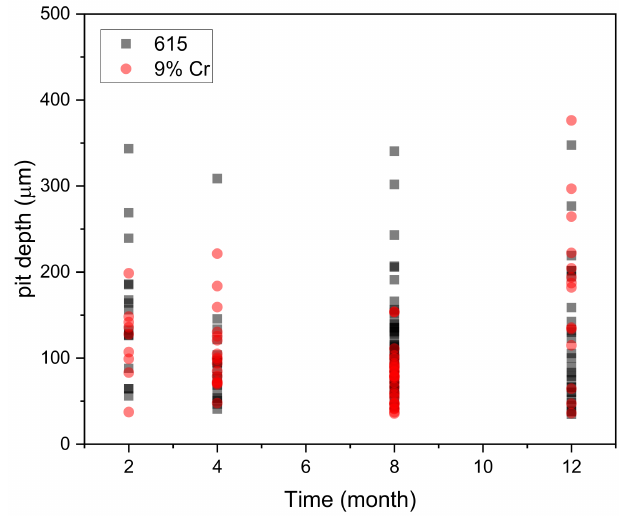
Figure 12. Pit depth distribution as a function of